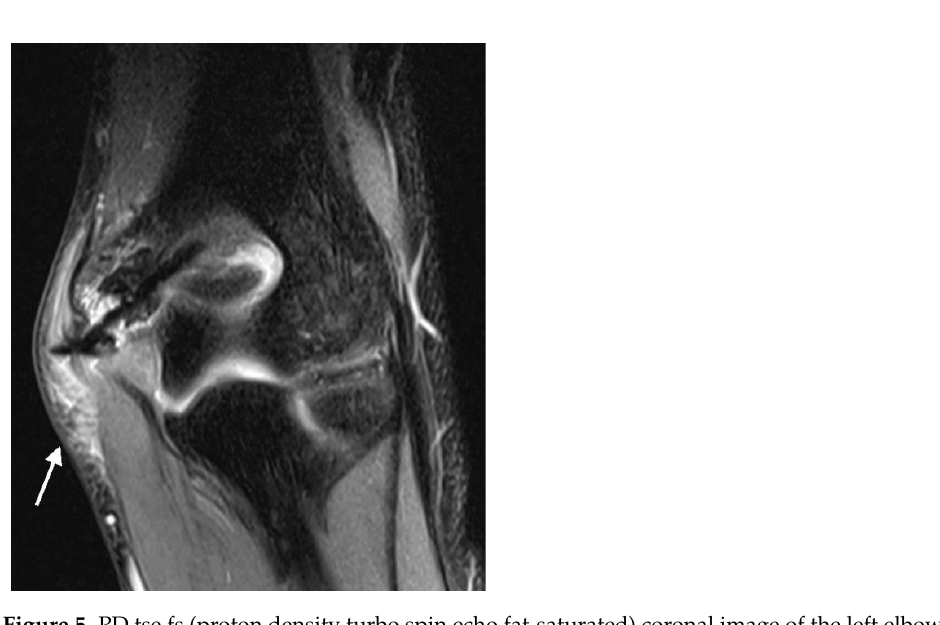
Figure 7. T2 trufi 3d we (true fast imaging with steady-state free precession three-dimensional water excitation) coronal image of the tibia of a 12-year-old boy with a tibial tuberosity fracture showing curvilinear hyperintense signals alternating with bands of signal loss (pile-up artifact) (arrow).